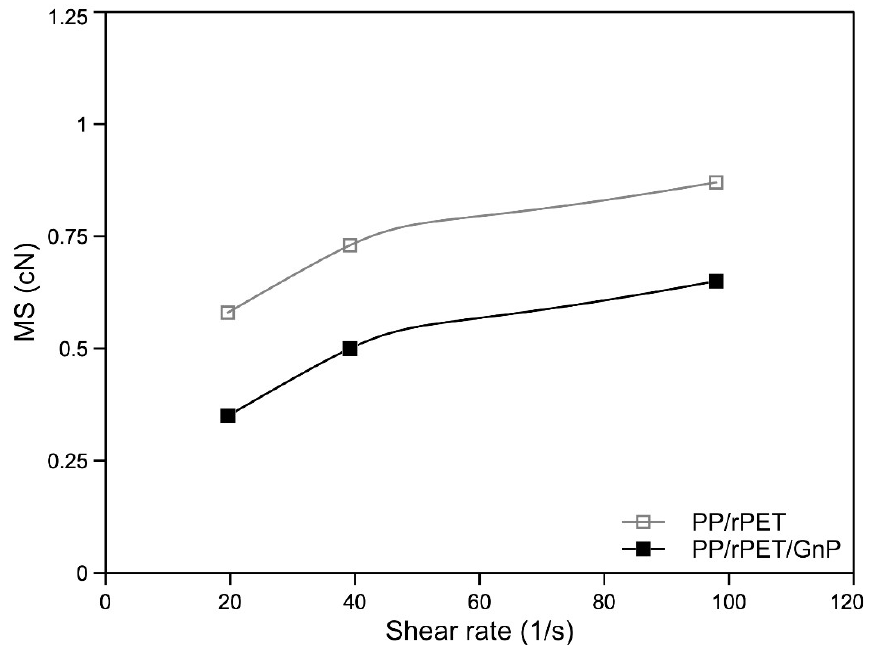
Nanomaterials 2021 , 11 , x Figure 3. Melt strength (MS) as function of the shear rate of the two systems. Figure 3. Melt strength (MS) as function of the shear rate of the two systems.